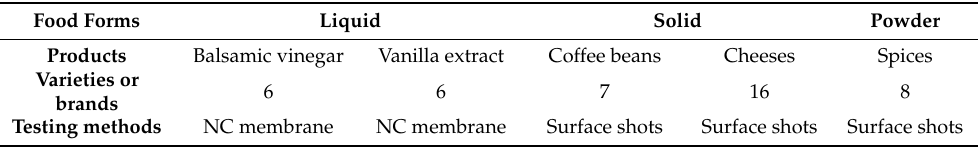
Table 1. Summary of food samples tested in the